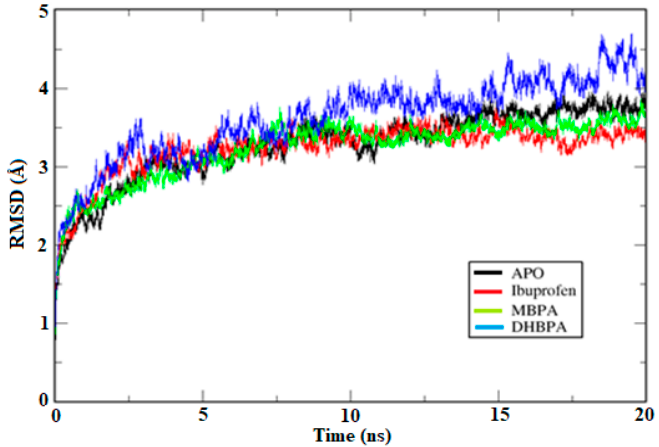
Figure 4. Root-mean-square deviation of atomic positions (RMSD) graph of COX-2 with compounds plotted in the XMGrace program.